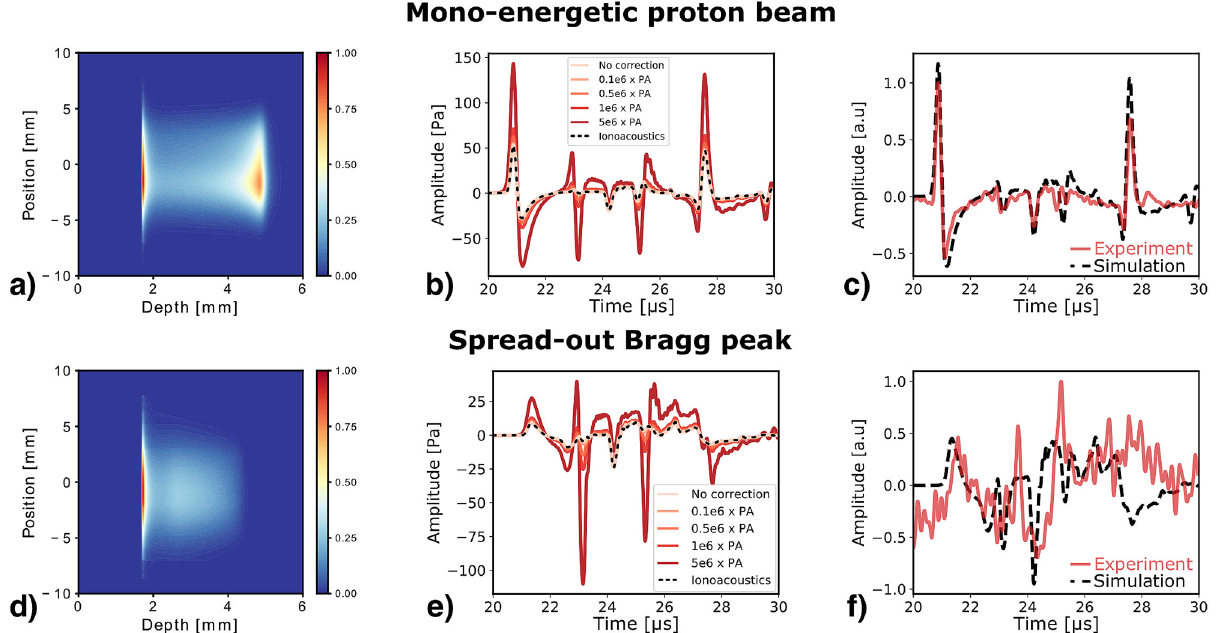
Figure 5. Water luminescence simulations and resulting pressure. ( a ) Energy deposition of the optical photons for the mono-energetic proton beam obtained from Fluka2021.1beta and ( b ) resulting ionoacoustic signal depending on the correction factor applied to the photoacoustic contribution (PA). ( c ) Comparison between the measurement with India ink using the mono-energetic beam and the simulation with a correction 5 factor of 5 × 10 . ( d ) Energy deposition of the optical photons for the spread-out Bragg peak obtained from Fluka2021.1beta and ( e ) resulting ionoacoustic signal depending on the correction factor applied to the photoacoustic contribution. ( f ) Comparison between the measurement with India ink using the spread- 5 out Bragg peak and the simulation with a optical photon correction factor of 5 × 10 . All the experimental measurements have been averaged over 3000 acquisitions and filtered using PyWavelets Python